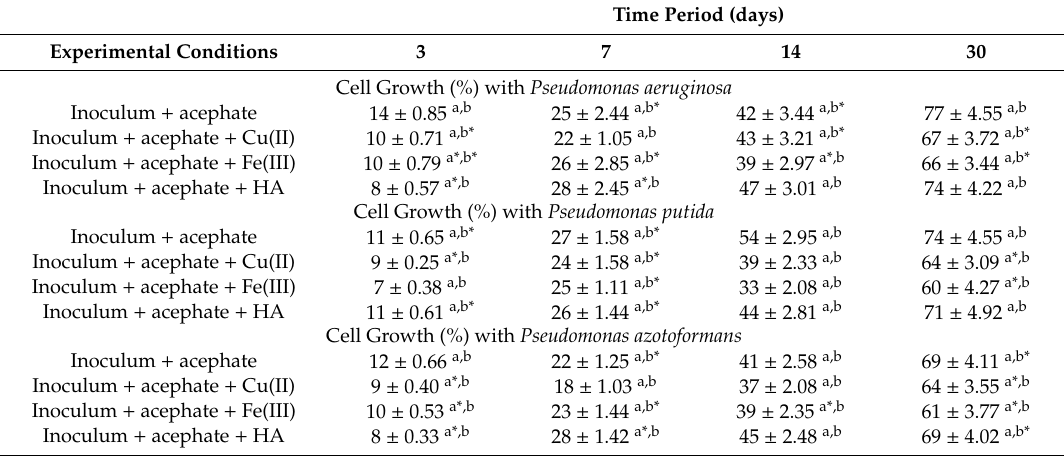
Table 1. UV—visible study (at 600 nm) for cell growth (%) under the influence of acephate / humic acid / metal ions by three bacterial strains in M9